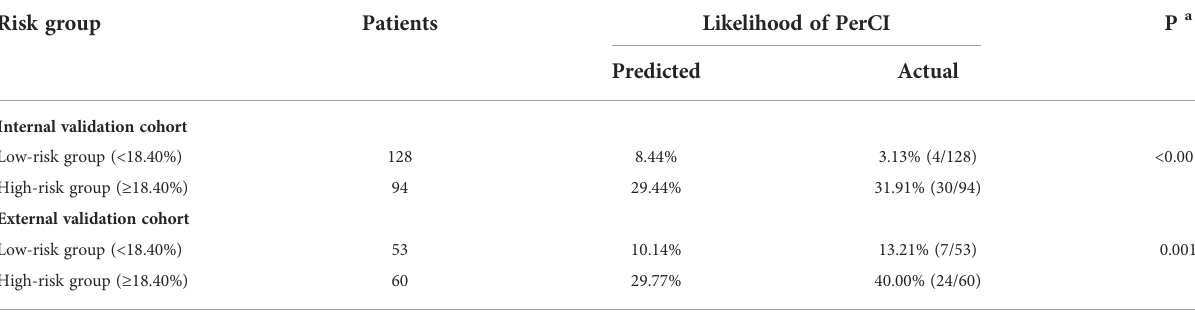
TABLE 4 Risk strati fi cation of patients in the validation cohorts based on the fi nal machine learning model. Risk group